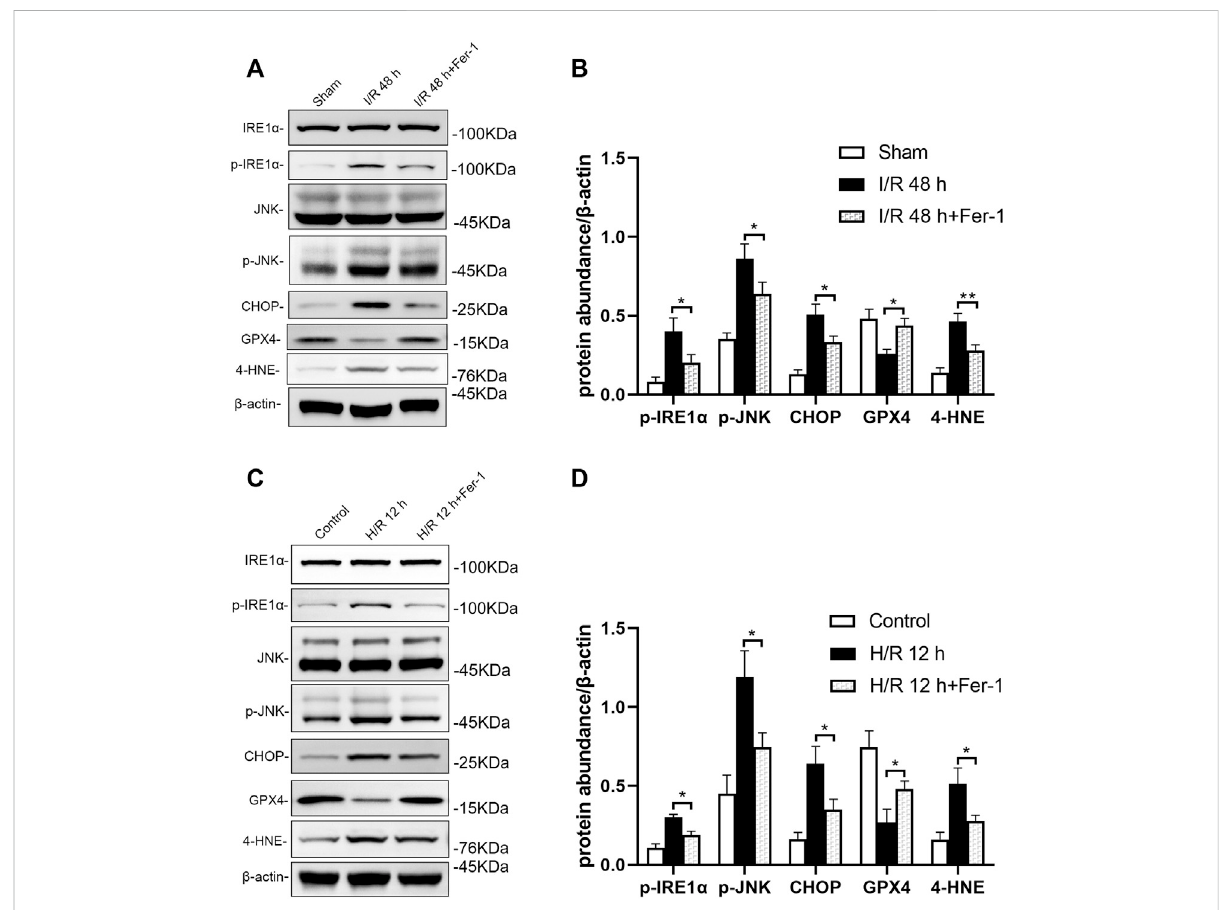
FIGURE 8 Inhibition of ferroptosis attenuates IRE1/JNK pathway in mice after I/R and HK-2 cells after H/R. Western blotting detection (A) and protein synthesis (B) of p-IRE1 α , p-JNK, and CHOP in mice at 48 h after I/R. Due to the death of mice, N = 5 for each group. Western blotting detection (C) and protein synthesis (D) of p-IRE1 α , p-JNK, and CHOP in HK-2 cells at 12 h after H/R. Statistical signi fi cance is denoted as *: p < 0.05, **: p < 0.01 in two